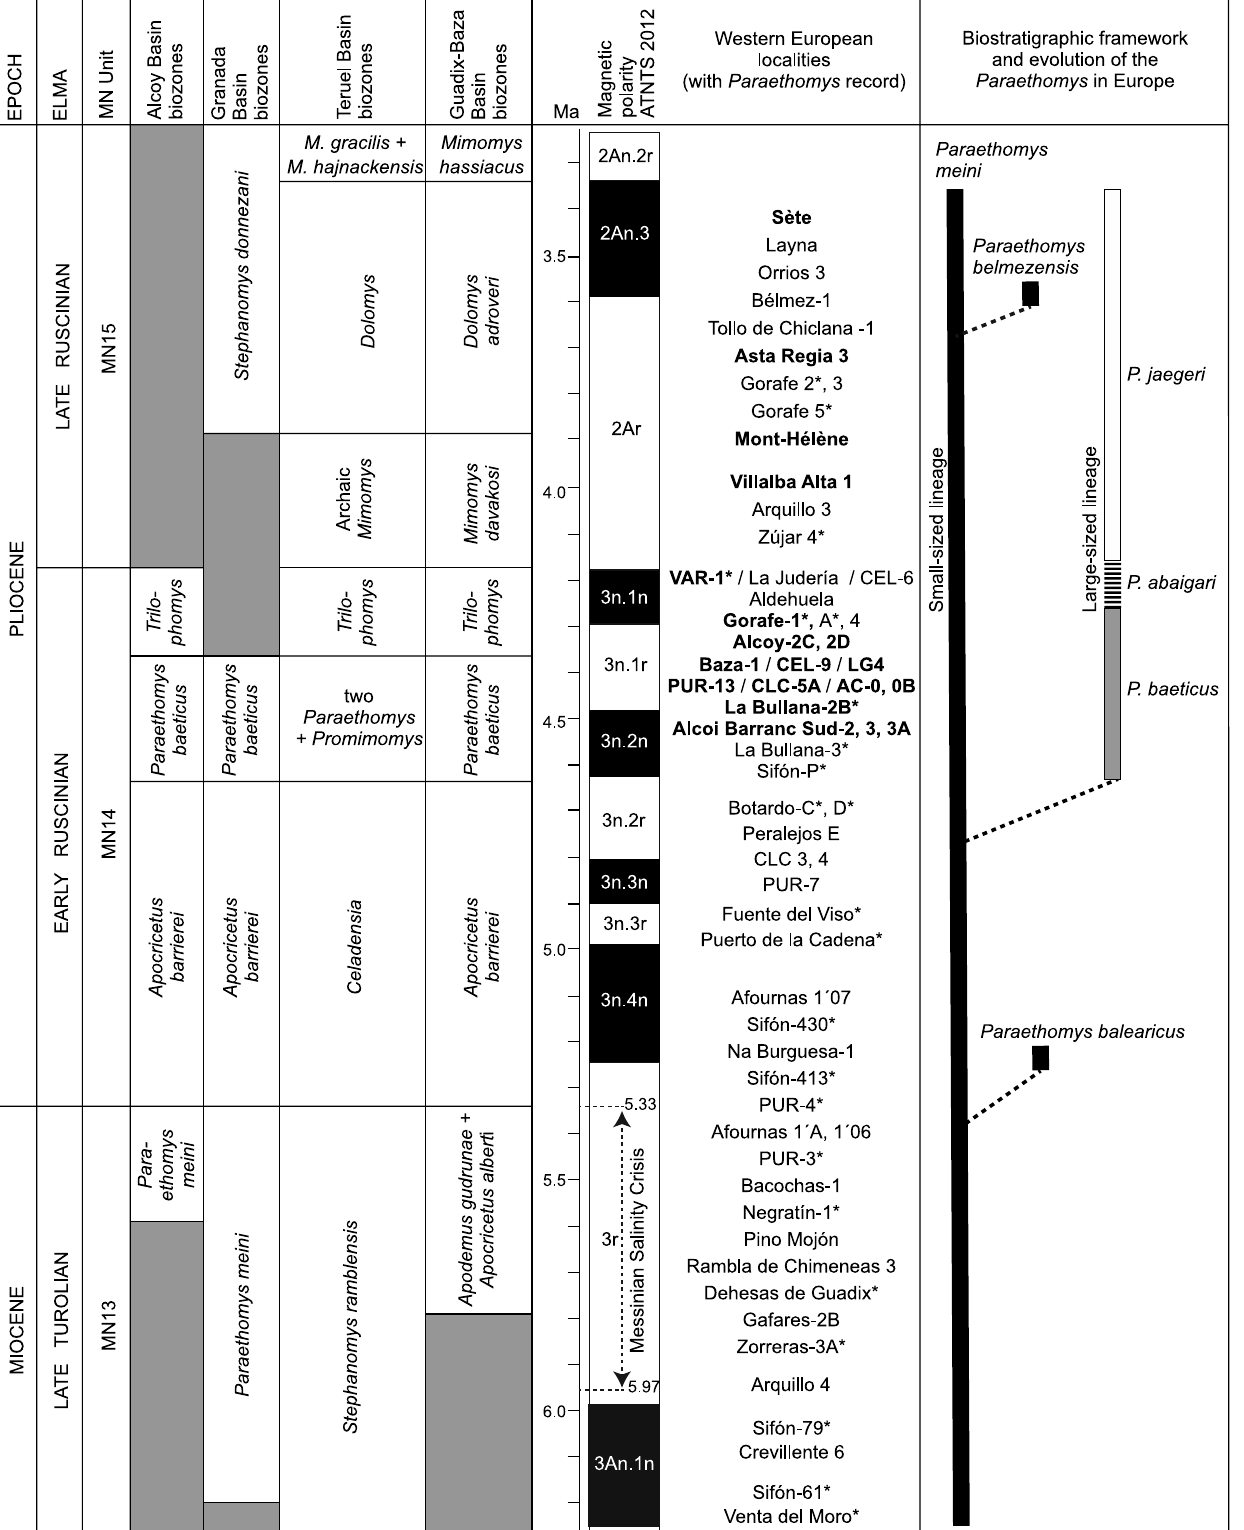
Fig. 5. Biostratigraphic distribution and evolution of the European Paraethomys species, showing their chronological ranges. The localities marked with an asterisk are calibrated with paleomagnetic data (Opdyke et al. 1997; Martín-Suárez et al. 1998, 2000; Oms et al. 1999; Gibert et al. 2013; Garcés et al. 1998, 2001; Hüsing et al. 2010; Mansino et al. 2015b; Piñero et al. 2017b, 2018). The sites with two species of Paraethomys in coexistence are in bold. Abbreviations: AC, Alcoi Cristian; ATNTS, Astronomically Tuned Neogene Time Scale; CEL, Celadas; CLC, Calicasas ELMA, European Land Mammal Ages; LG, La Gloria (Adrover et al. 1993); M. , Mimomys ; MN, Mammal Neogene; P. , Paraethomys ; PUR, Purcal; VAR, Villalba Alta